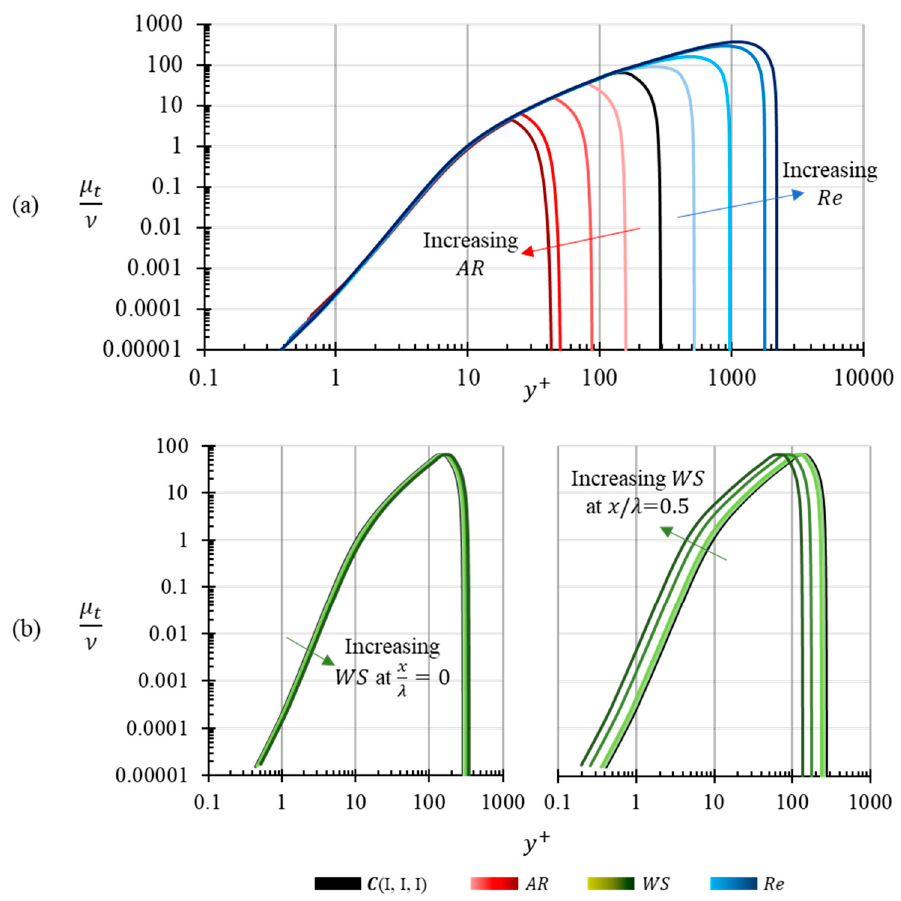
Figure 15. Influence of parameters on normalized eddy viscosity across channel. ( a ) AR -variation and Re -variation, and ( b ) WS -variation at the peak (cid:4672) (cid:3051)